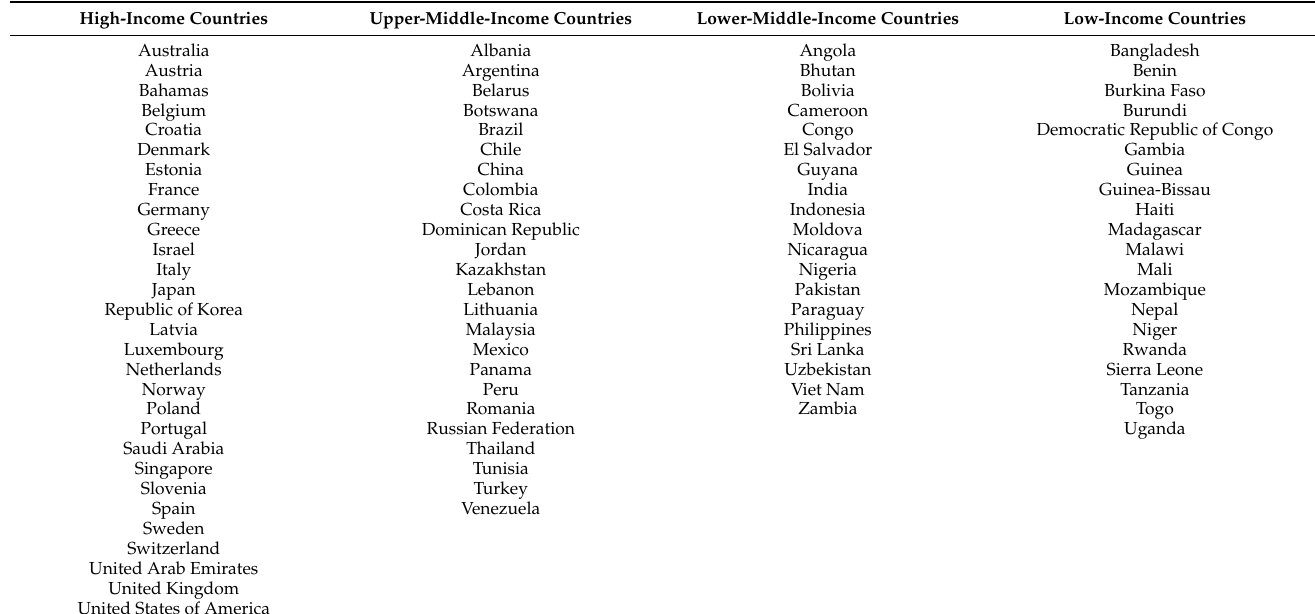
Table A1. Countries included in the analysis are classified by